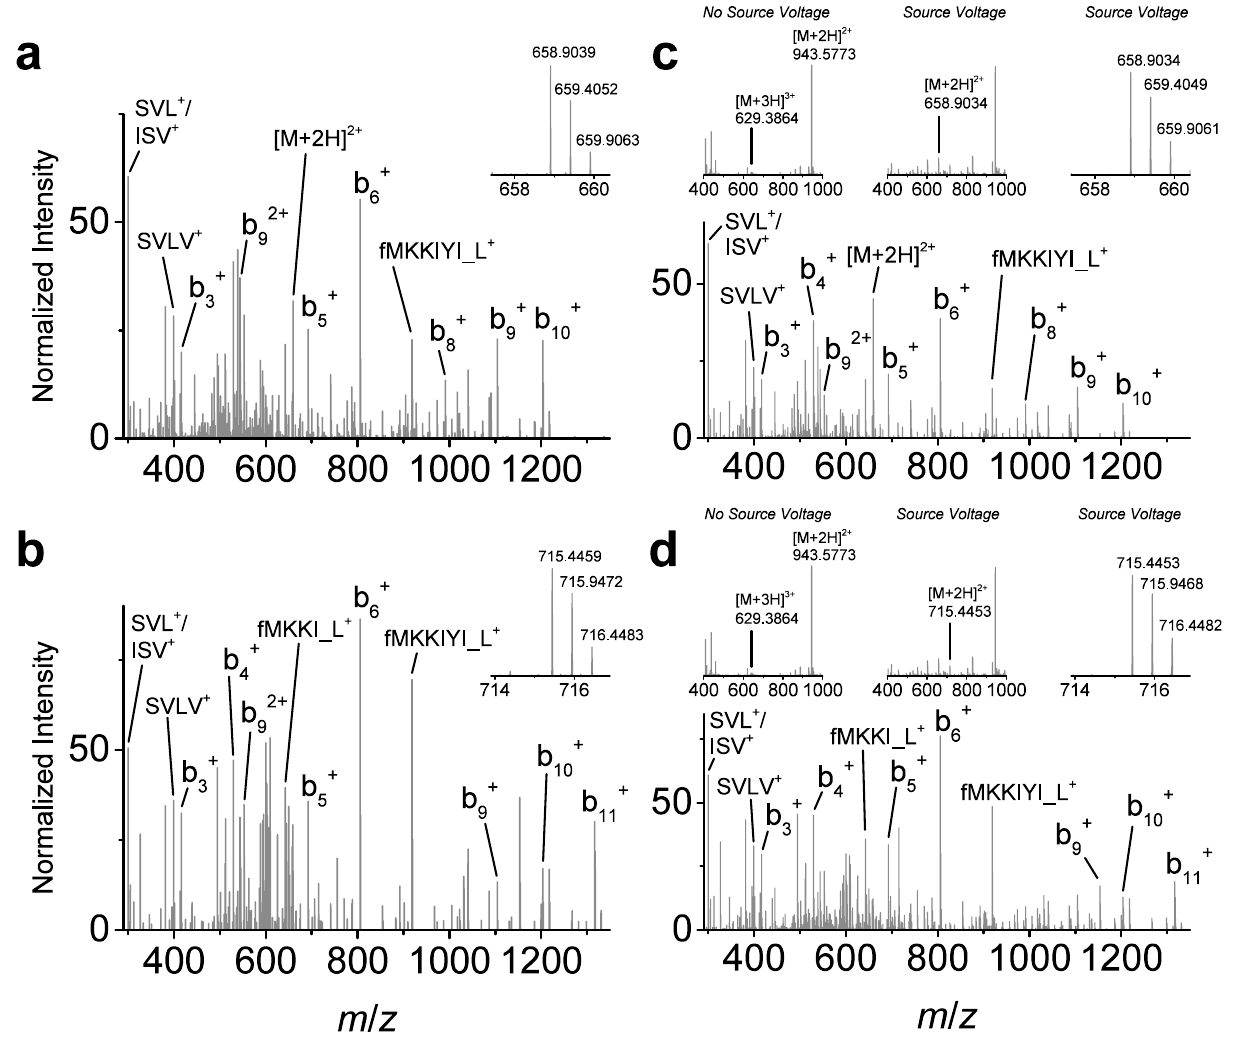
Figure 3. PBP2a mecC protein detection using in-source generated peptide-like fragments and MS/MS fragmentation. ( a , b ) Source-induced dissociated N-terminal peptide-like fragments from PBP2a mecC (ATCC MRSA isolate BAA-2312) at precursor m / z 658.9042 ( a ) and m / z 715.4462 ( b ) for selected ion monitoring (insets) and associated representative targeted MS/MS spectra (n ≥ 100). ( c ) Synthetic peptide confirmation of source-induced dissociated peptide-like precursor m / z 658.9042 and associated MS/MS spectrum (inset spectrum series displays peptide spectrum without in-source energy, with in-source dissociation, and magnified spectrum of target precursor following in-source dissociation). ( d ) Synthetic peptide confirmation of source- induced dissociated peptide-like precursor m / z 715.4462 and associated MS/MS spectrum (inset spectrum series displays peptide spectrum without in-source energy, and magnified spectrum of target precursor following in-source dissociation). Data collection for synthetic peptides was repeated multiple times on different MS instruments (n =